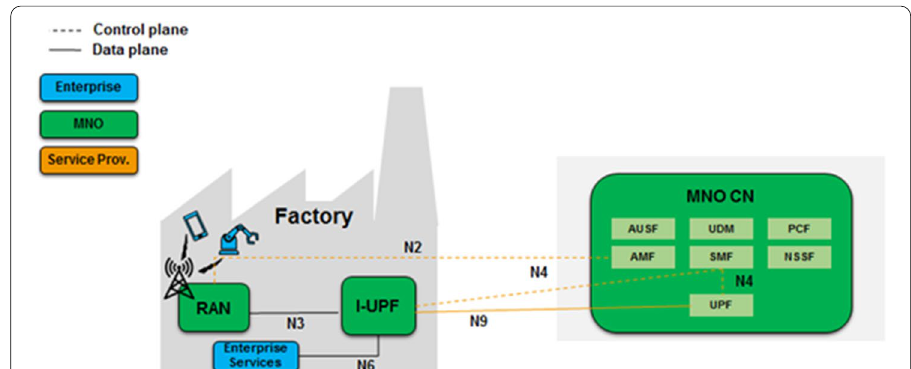
Fig. 11 MNO’s Private Core Network architecture with I‑UPF local breakout